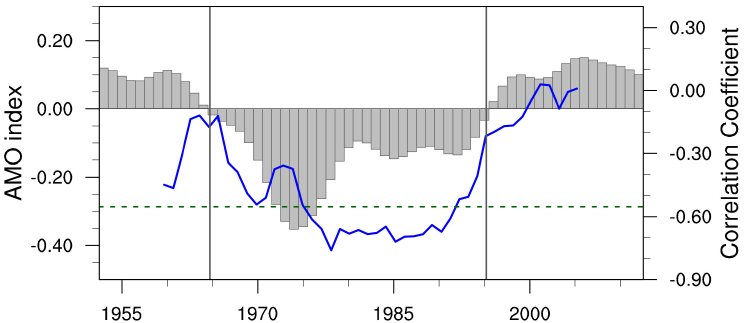
Figure 3. The 11-year low-pass-filtered AMO index (bar) and 13-year sliding correlation coefficient between Niño3.4 index and L AST (blue curve) in spring during 1953–2012. The green dashed line indicates the correlation coefficient exceeding the 95% confidence level.